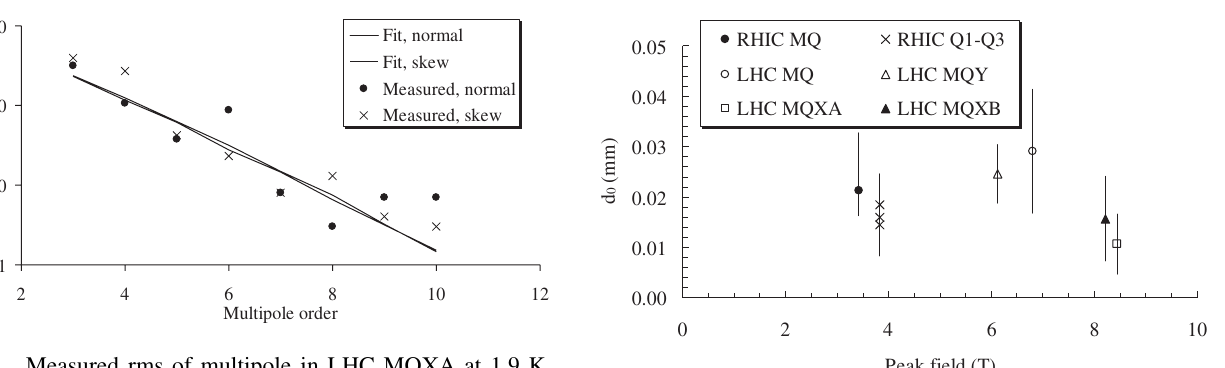
FIG. 1. Measured rms of multipole in LHC MQXA at 1.9 K (markers), and best fit through simulations with d